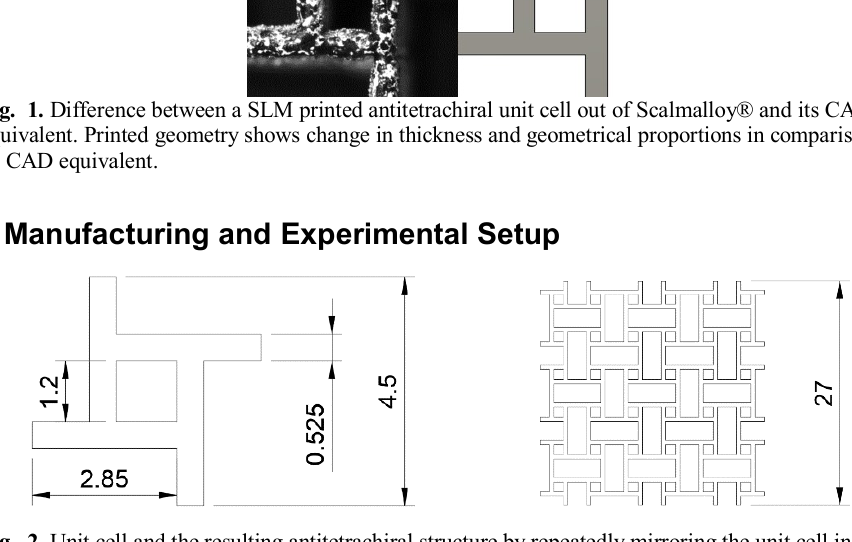
Fig. 2 . Unit cell and the resulting antitetrachiral structure by repeatedly mirroring the unit cell in two directions in space. All dimensions in